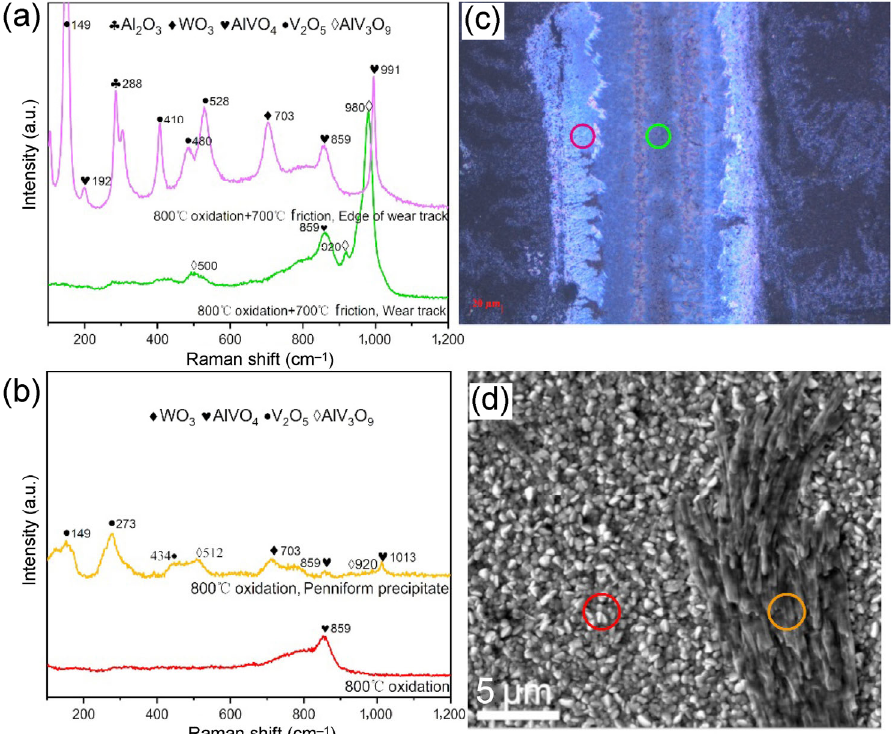
Fig. 6 Raman spectra of wear track of the film after oxidized at 800 °C followed by friction at 700 °C (a), and of the film after oxidation at 800 °C